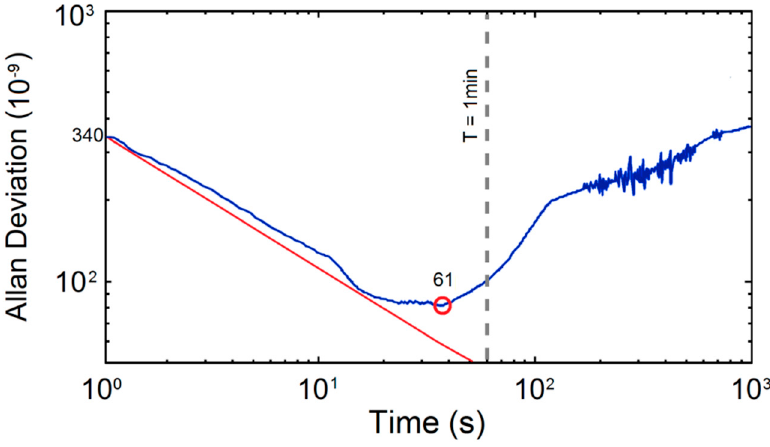
Figure 6. Allan deviation of the acquisition data of 60 ppmv CO